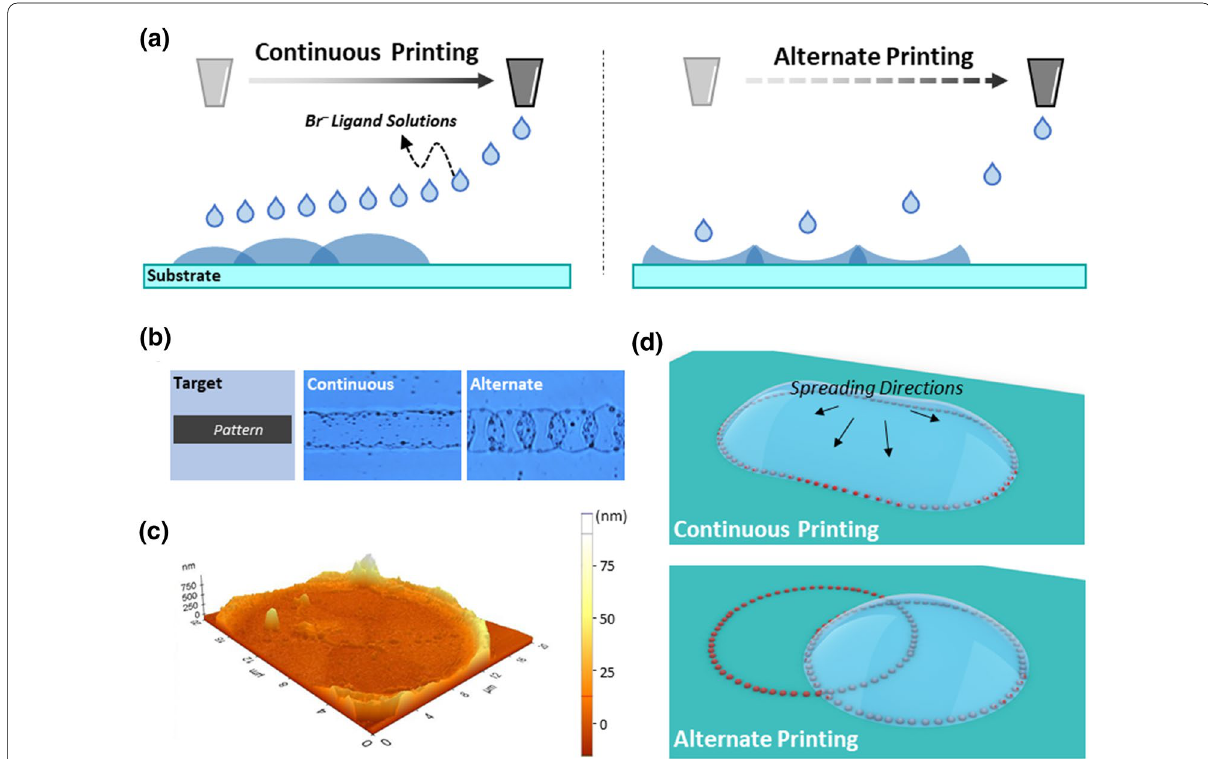
Fig. 1 a Schematics of different fluid behaviors in the different printing modes (continuous and alternate). b Optical images of NH 4 Br-printed glass substrate without NC thin films showing continuously (middle) and alternately printed patterns (right). c Atomic force microscopy (AFM) data of an alternately extracted droplet on the glass substrate. d Schematic illustration of surface morphology created by the coffee-ring effect (red particles represent oleic acid, oleylamine, or